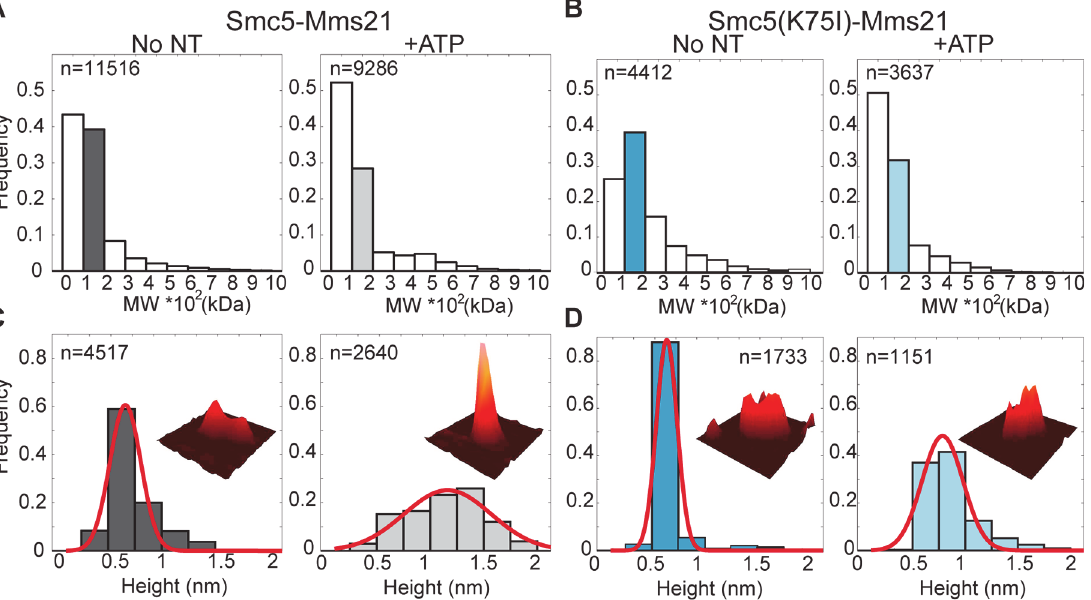
Fig 6. High-throughput SFM image analysis shows Smc5-Mms21 heterodimer is rearranged in an ATP-dependent manner. A . Volume distribution analysis of Smc5-Mms21 with (+ATP) or without ATP (No NT). B . Volume distribution analysis of Smc5(K75I)-Mms21 with (+ATP) or without ATP (No NT). C . Height distribution analysis of Smc5-Mms21 heterodimers between 100 and 200 kDa. Bins are highlighted with the same color as in panel A, dark and light gray, without and with ATP respectively. Average height of the 10% brighter pixels changed from 0.53 ± 0.2 nm (SD) without ATP to 1 ± 0.57 nm (SD) after ATP binding. D . Height distribution analysis of Smc5(K75I)-Nse2 heterodimers between 100 and 200 kDa (bins highlighted in the same color as in panel B, blue and light blue, without and with ATP respectively). Average height of the mutant heterodimer was 0.51 ± 0.14 nm (SD) without ATP and 0.66 ± 0.27 nm (SD) after ATP addition. n: number of analyzed particles; MW: molecular weight, kDa: kilo Daltons; nm: nanometers. Insets show representative SFM images (70x70 nm) of the heterodimers analyzed as 3-D view all at the same height (maximum height 1.5 nm). Red line is the normal distribution fit to data.